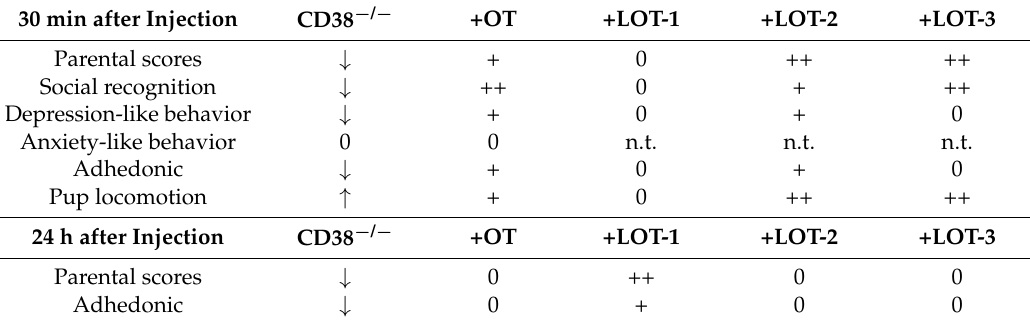
Table 1. Summary of the behavioral profiles and effects of Oxytocin (OT) and the Lipo-oxytocins (LOTs) on deficits in CD38 knockout( − / − )mice. The arrows indicate increases or decreases in the phenotypes in CD38 − / − mice compared with those in CD38 +/+ mice. ++ or + indicates recovery; 0 represents no effect. OT, oxytocin; LOT, lipo-oxytocin; n.t., not tested. 30 min after Injection CD38 − /